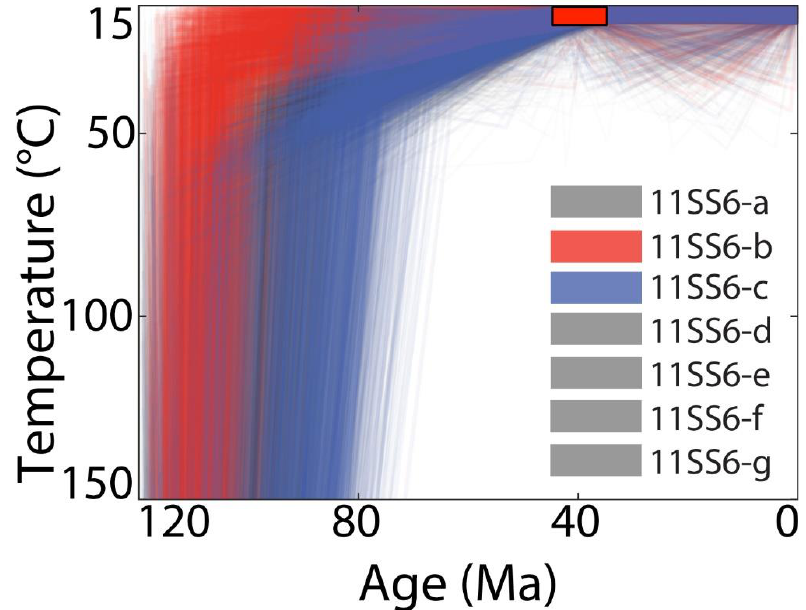
Figure 7. Thermal model results for individual single grain runs from sample 11SS6 in [13]. No dates were rejected by [13]. Red represents the oldest grain (11SS6-b) and blue the youngest (11SS6-c) and are shown as accepted individual time-temperature paths from post “burn in” model iterations. The allowable thermal histories of the other 5 grains all are focused on the zone of overlap between these two and are plotted in gray beneath the blue and red. The low temperature constraint is shown as red box. The extent of this figure represents the time-temperature bounding box used in all model runs.